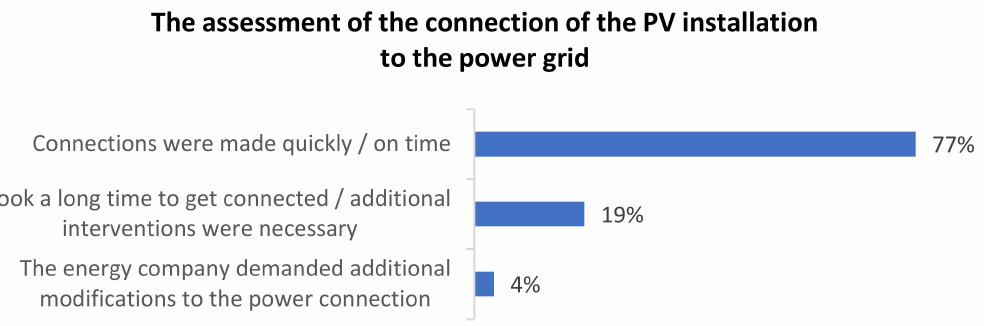
Figure 5. Answers to questions about connecting the PV installation to the power grid ( n = 57). Source: own